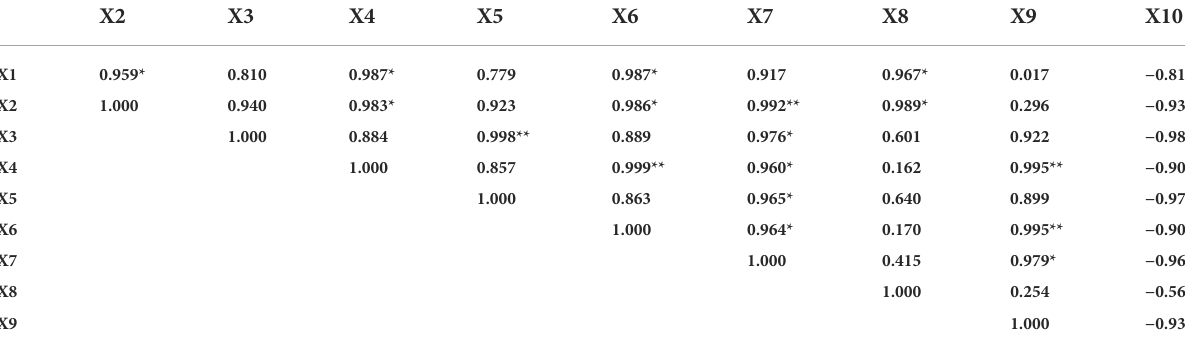
TABLE 4 Pearson correlations from the studied parameters in this